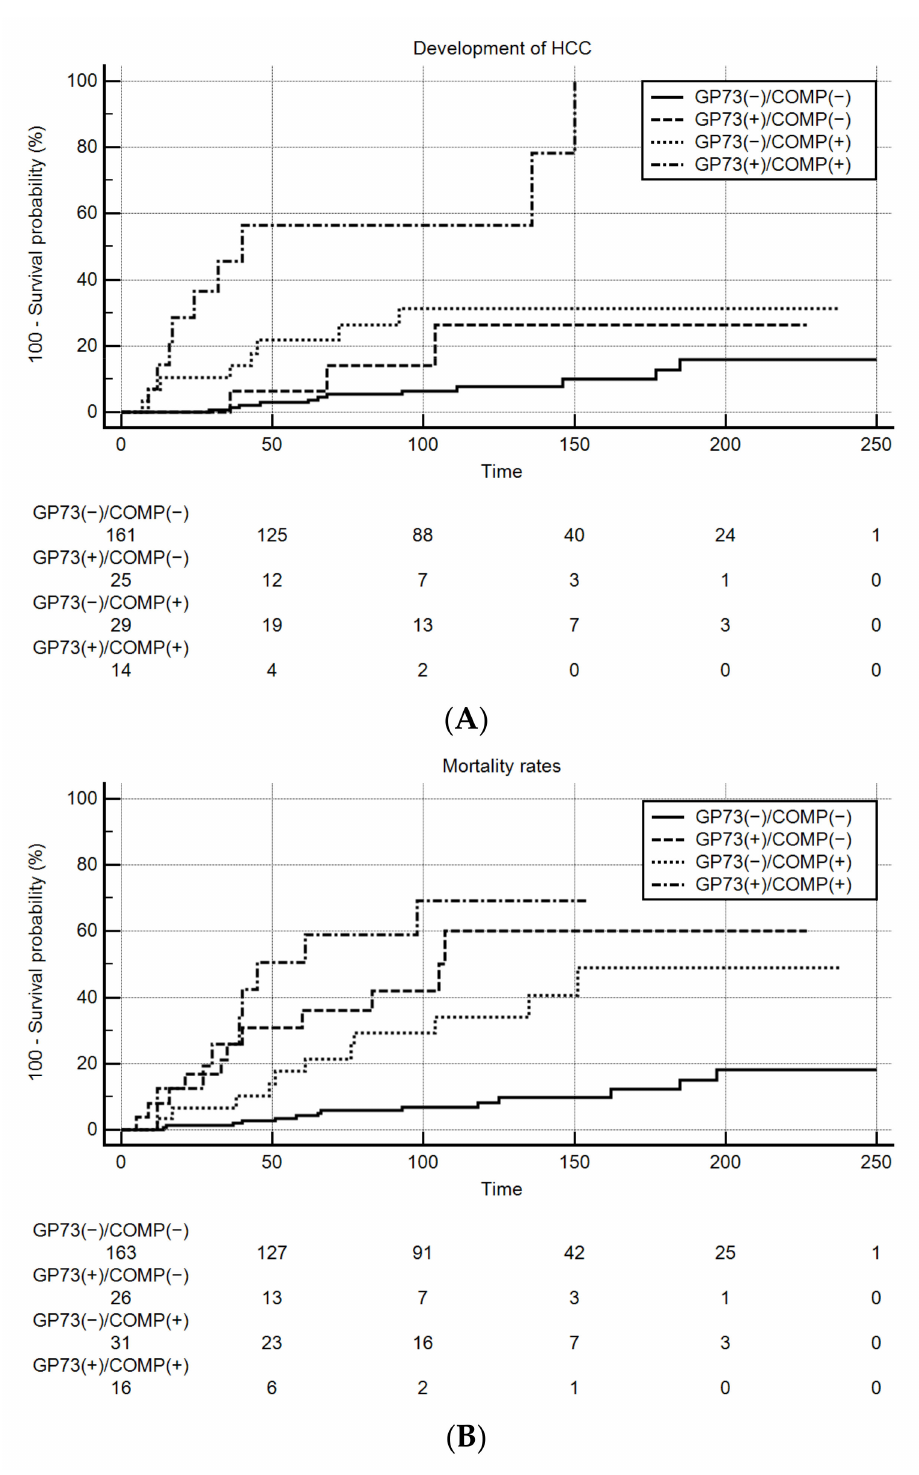
Figure 5. Kaplan-Meier analysis for COMP and GP73 as predictive markers of HCC development and survival. GP73(+)/COMP(+) patients characterized by: ( A ) Higher rates of HCC development during follow-up ( P < 0.001; analysis was performed in 229 patients with follow-up more than 6 months by excluding patients with HCC at baseline), ( B ) increased liver-related mortality ( P <